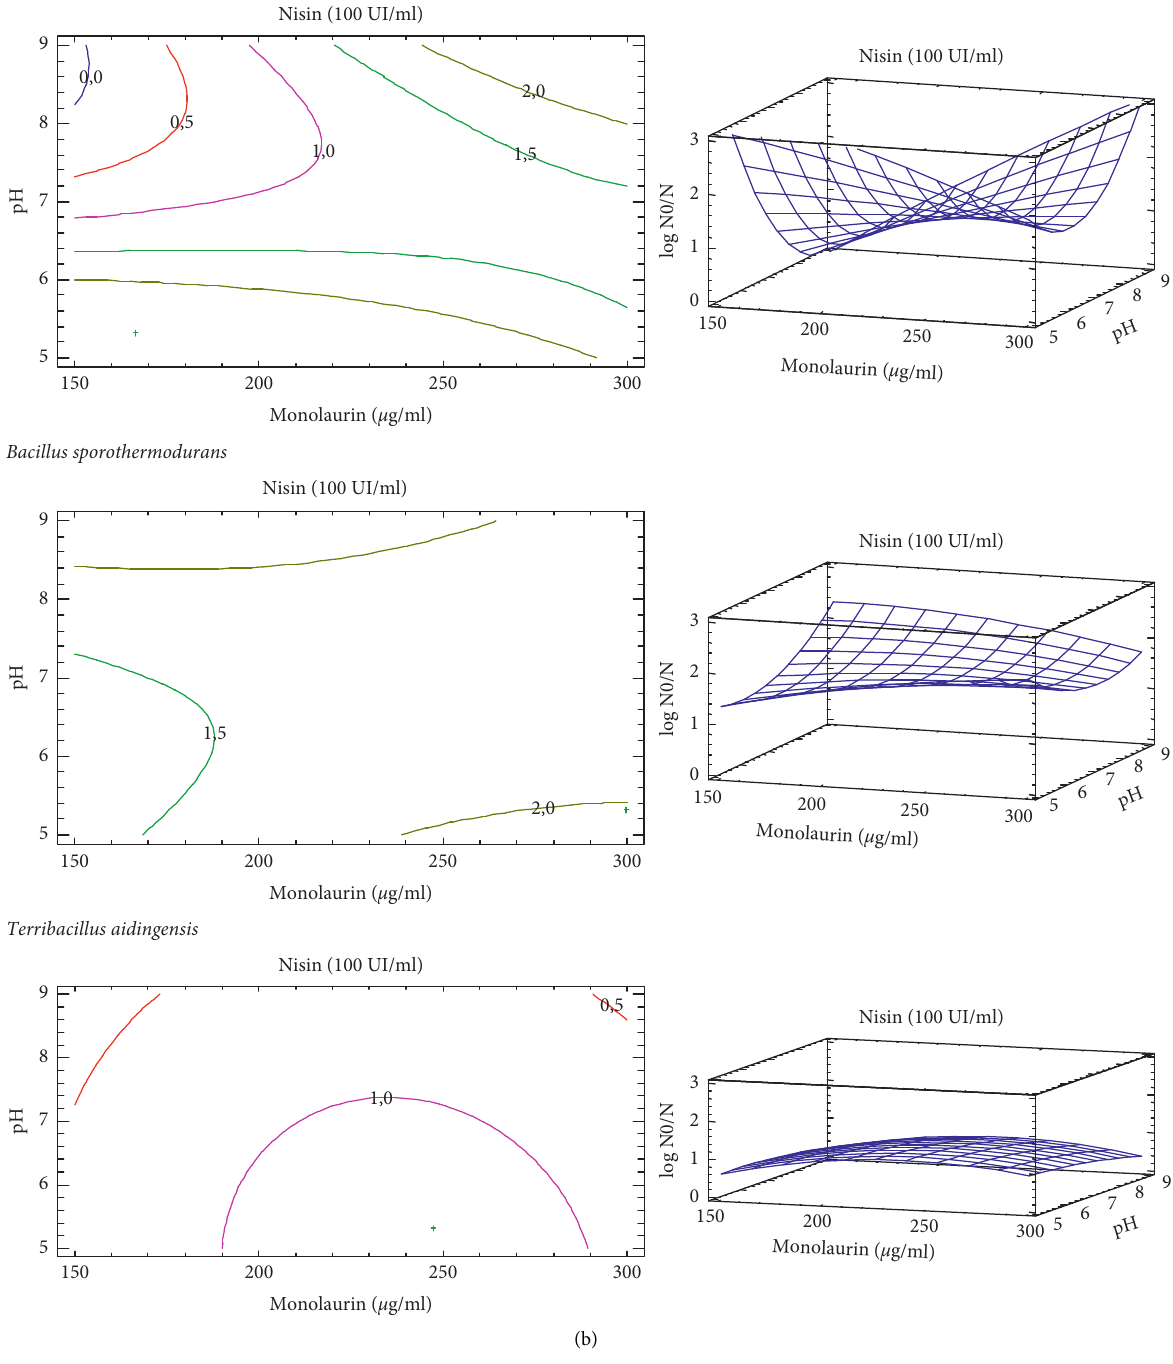
Figure 3: Response surface and contour plots showing the effects of monolaurin and pH on the spores’ inactivation in distilled (a) water and (b) milk ∗ The data on the contour maps are log N 0 /N. N 0 represents the plate count of the untreated spore suspension (10 7 spores/ml), and N represents the plate count after treatment with antimicrobial